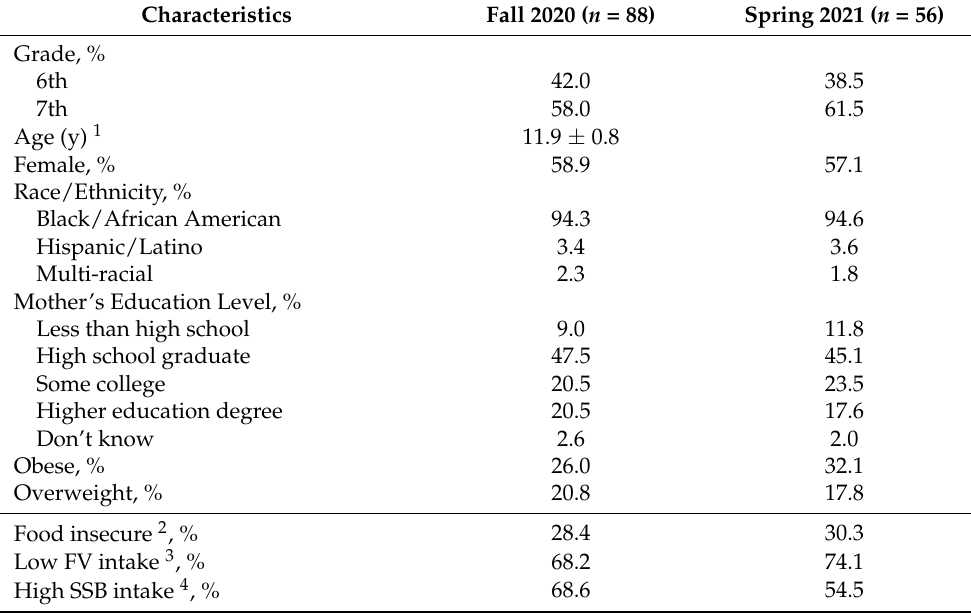
Table 1. Descriptive sample